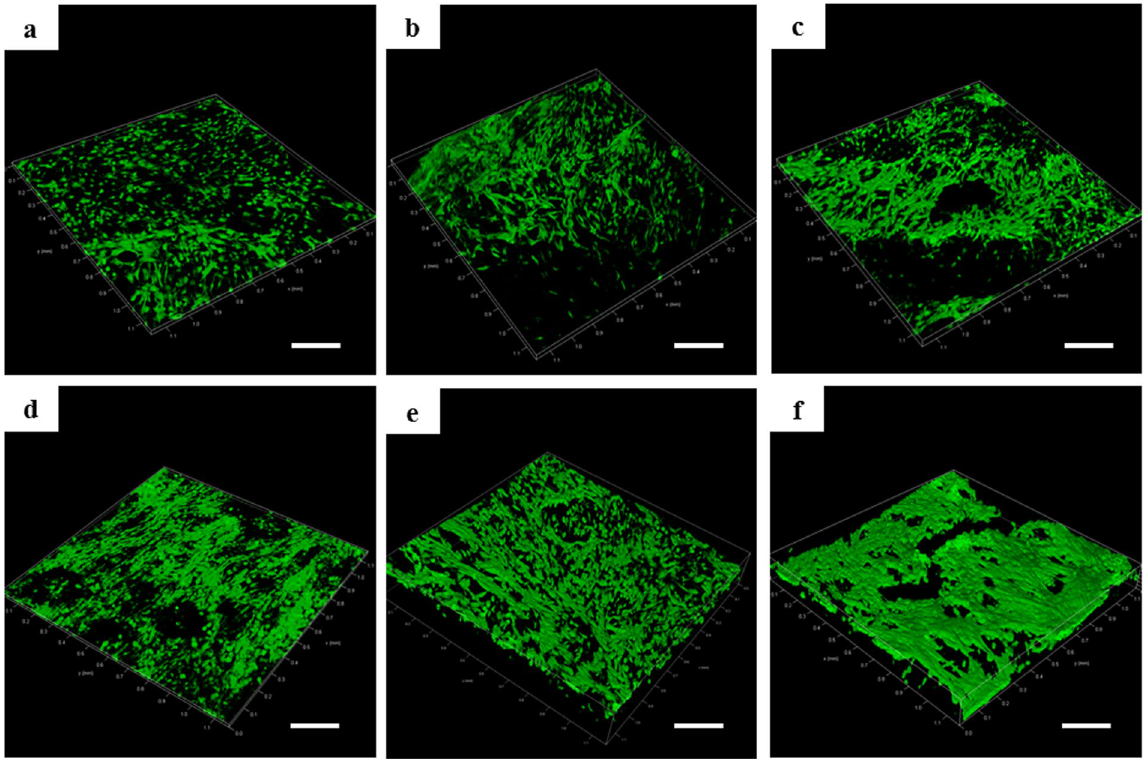
Figure 3. Confocal images of BMSCs stained with FDA in static-2D group after 3 days ( a ), 7 days ( d ), static-3D group after 3 days ( b ), 7 days ( e ), and RCCS-3D group after 3 days ( c ), 7 days ( f ). Scale bar = 200 μ m.